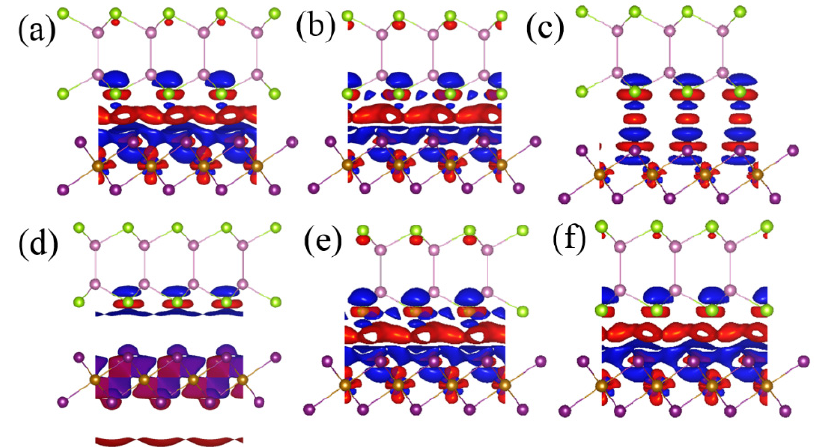
Figure 5. Di ff erential charge density of C-1 to C-6, ( a – f ). The red and blue colors represent charge accumulation and depletion, respectively. The isosurface value is of 0.0003 e · Å − 3 . The green, pink, purple and brown balls represent Se, In, I, and Fe atoms, respectively.